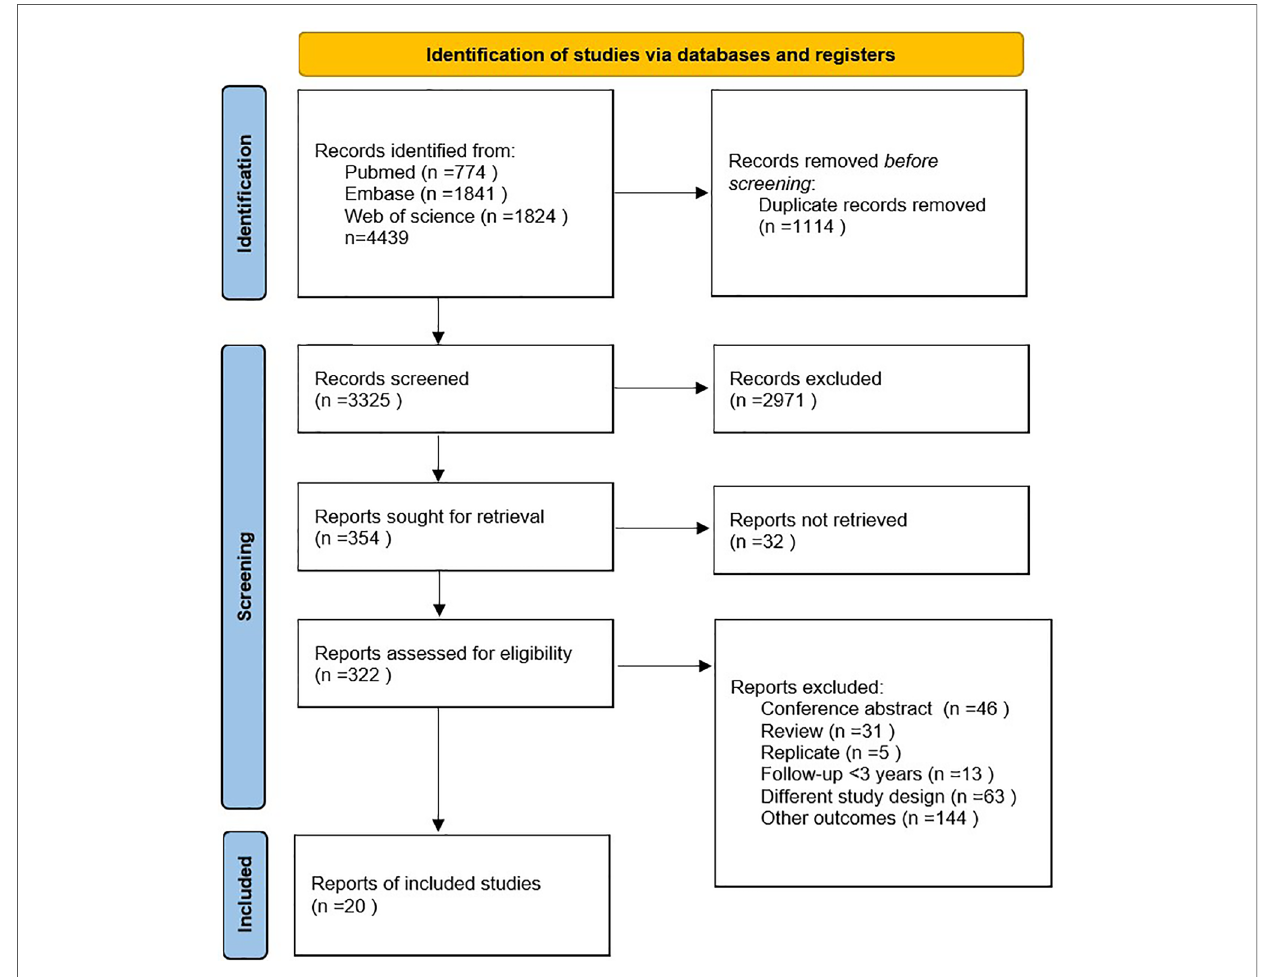
FIGURE 1 Flowchart for searching and selection